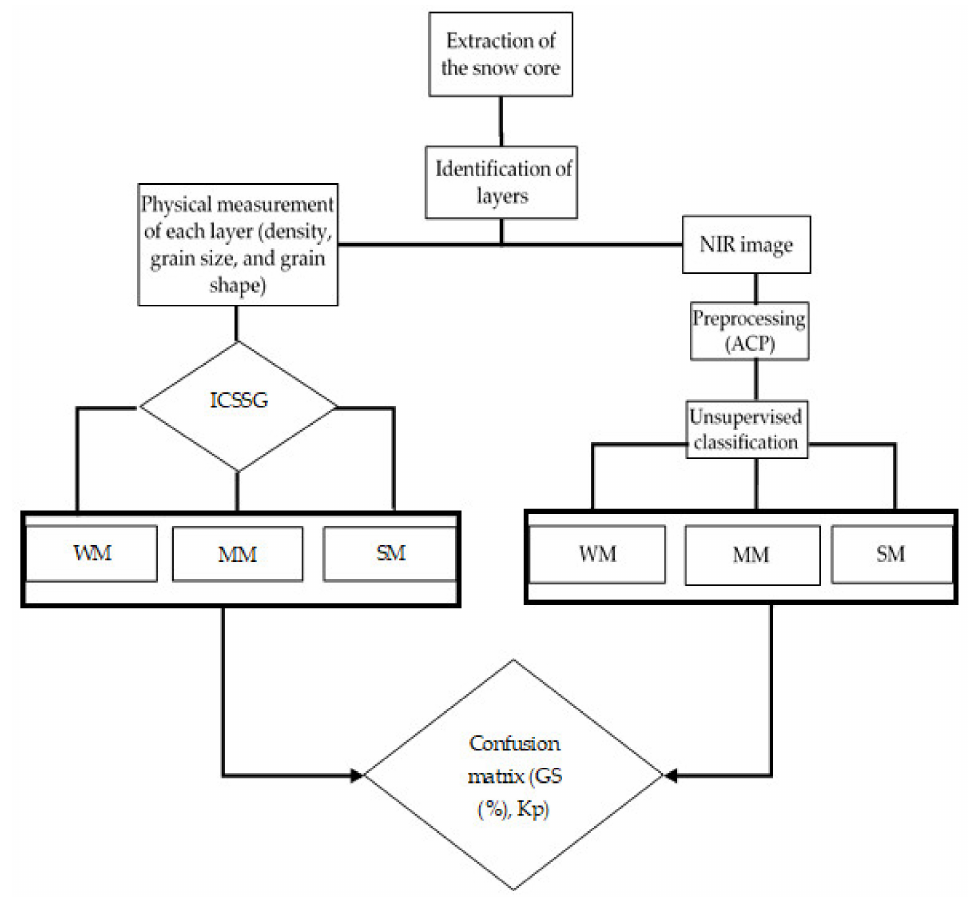
Figure 7. Flowchart of the methodological approach. WM—weakly metamorphosed; MM— moderately metamorphosed; SM—strongly metamorphosed; GS—global success; Kp—kappa index; ICSSG—International Classification for Seasonal Snow on the